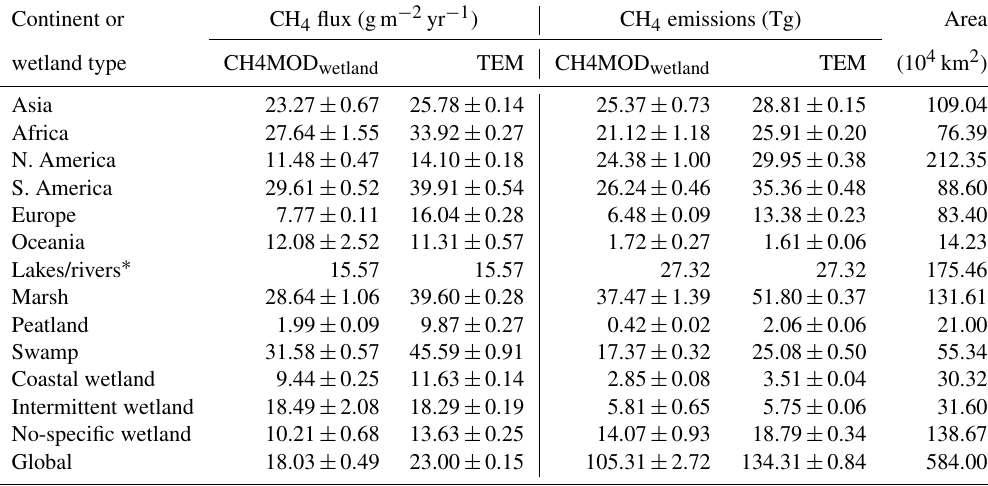
Table 3. CH 4 simulations by CH4MOD wetland and TEM for different continents and wetland types. All units are TgCH 4 yr − 1 ± 1 σ , where the standard deviation represents the interannual variation in the model